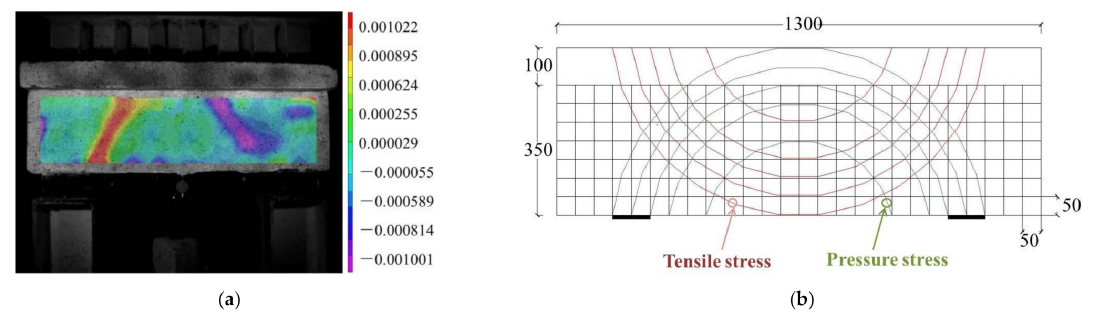
Figure 11. The full field strain distribution and principal stress trajectory of the beam by DIC of unreinforced deep T-section beam: ( a ) The full field strain distribution of the beam by DIC; ( b ) Principal stress